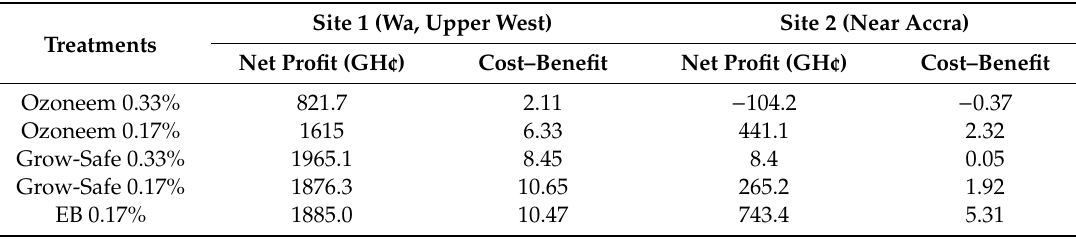
Table 2. Net profits and cost–benefit values for the effects of neem-based treatments aiming to control fall armyworm in maize in Ghana compared to the negative control. Emamectin benzoate (EB) is applied as a positive control.